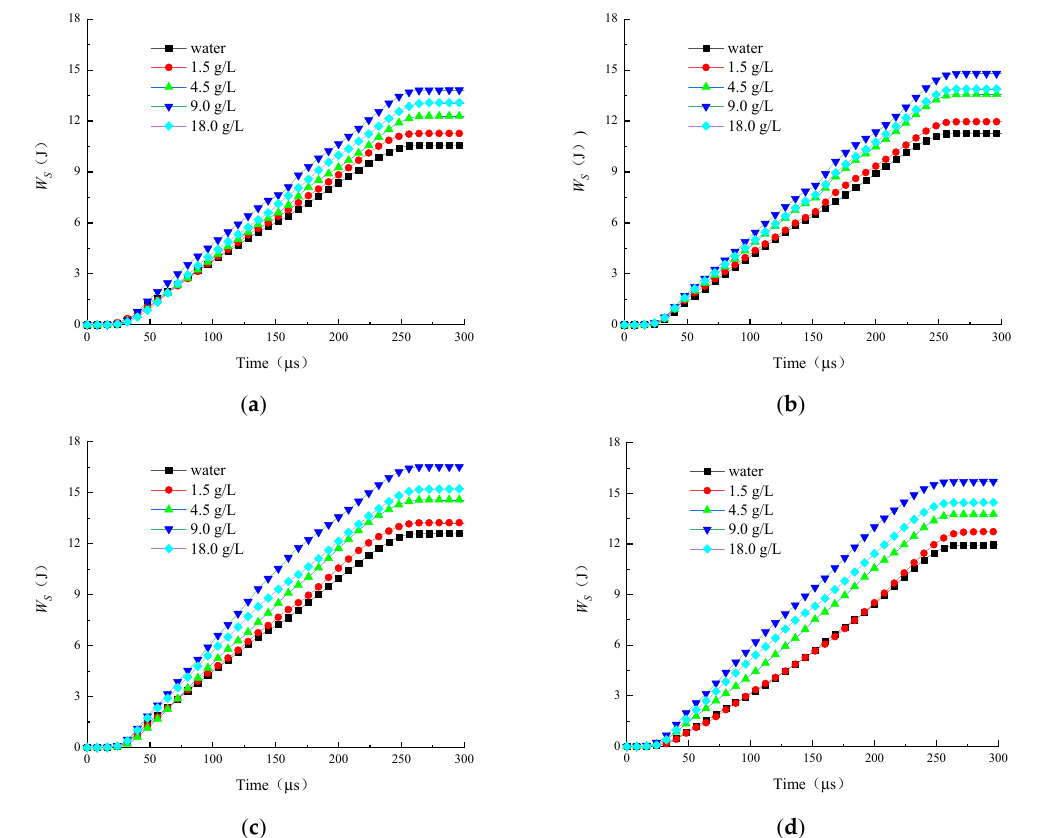
Figure 9. Curves of absorbed energy of cement soil specimens under different Na 2 SO 4 solution concentrations: ( a ) curing period of 3 days; ( b ) curing period of 7 days; ( c ) curing period of 14 days; and ( d ) curing period of 28 days.